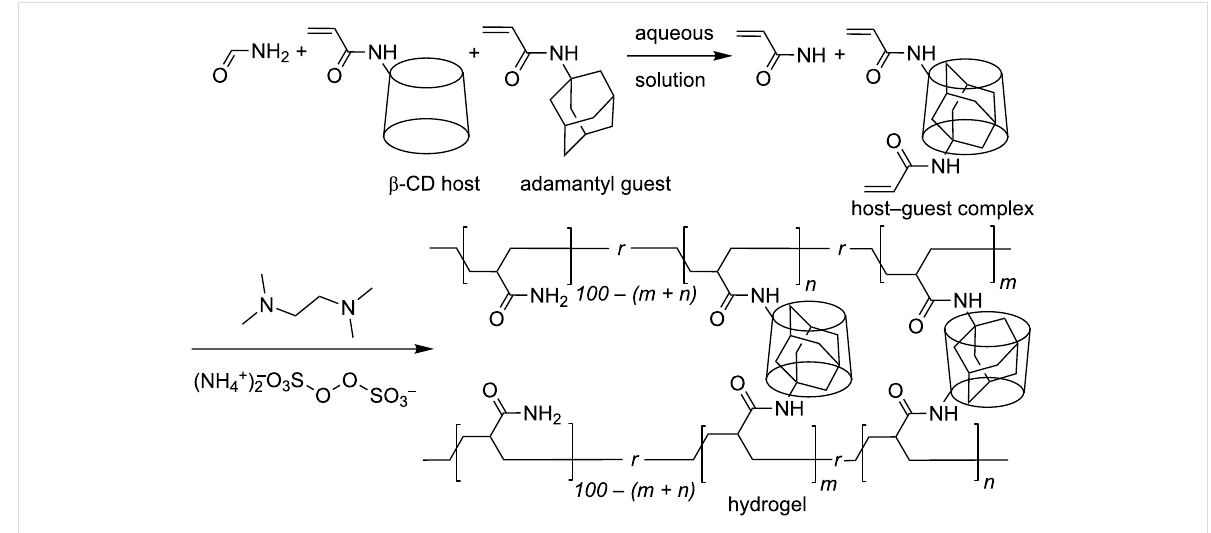
Figure 21: Preparation of a β -CD and adamantyl substituted acrylamide polymer hydrogel involving host–guest complexation between their β -CD and adamantyl substituents [108].